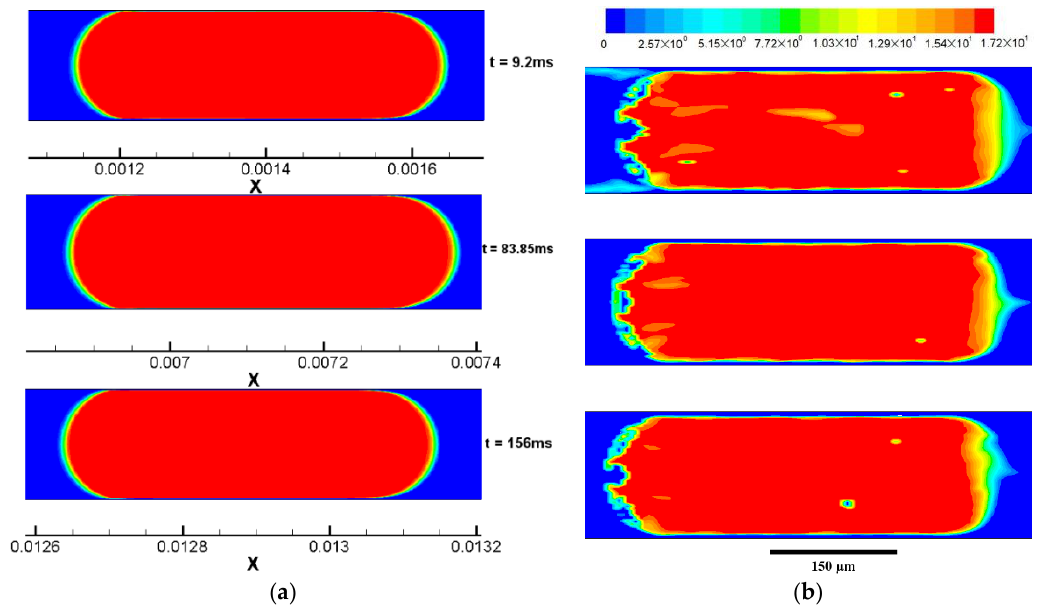
Figure 8. Liquid CO 2 drop at three time moments (t = 9.2 ms, t = 83.85 ms, t = 156 ms) in simulation case 1. ( a ) Drop profile of volume fraction, red color indicates α CO2 = 1; ( b ) drop profile of molar concentrations of CO 2 (c CO2 ) in water, color map on the top indicates the c CO2 value and red color indicates a nominal c CO2 of pure CO 2 (i.e., c CO2 = ρ/M). The other distinct CO 2 distribution profile emerges in simulation Case 6. According to Figure 6e.